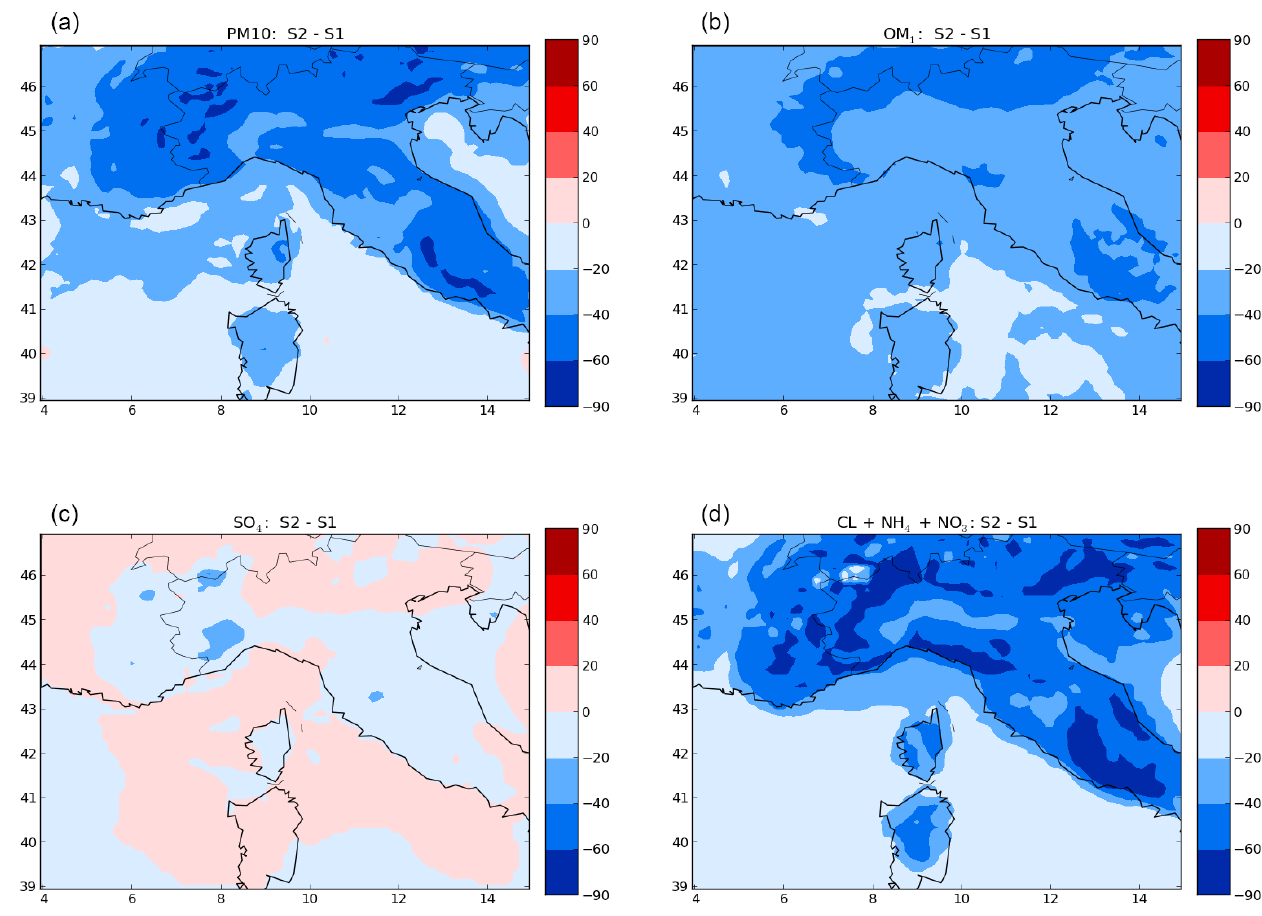
Figure D2. Maps of the relative differences of the concentrations of PM 10 (a) , OM 1 (b) , sulfate (c) and other inorganics (nitrate, ammonium and chloride) (d) in % between S1 and S2 (b, d) during the summer